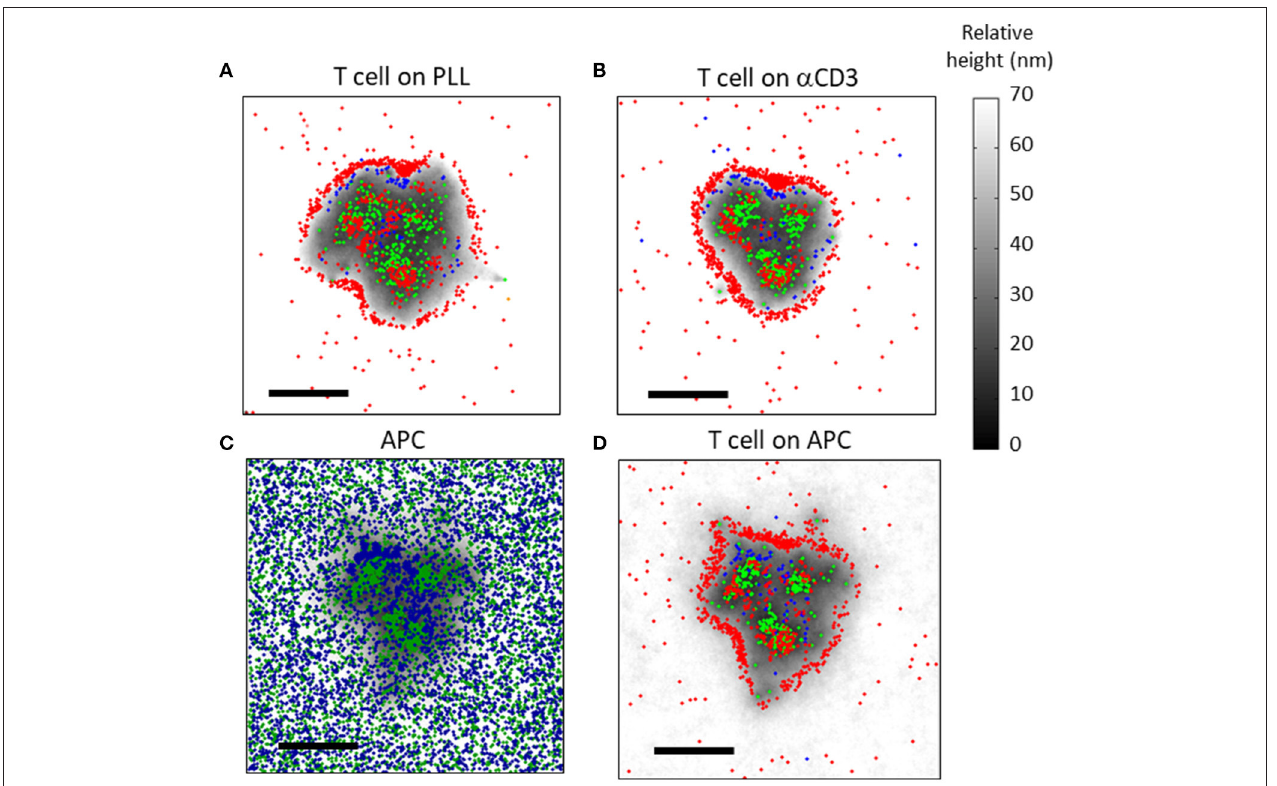
FIGURE 8 | Simulation results of molecular patterning at the immune synapse (A,B) The molecular patterning of TCRs (green), CD11 (blue) and CD45 (red) at the cell interface, on either (A) a PLL-coated or (B) an α CD3-coated coverslip. (C,D) The molecular patterning at the T cell-APC immune synapse. (C) ICAM (blue) and pMHC (green) molecules are shown at the PM of the APC. (D) TCRs (green), CD11 (blue) and CD45 (red) are shown at the PM of the T cell. Membrane height in panels (C,D) is marked by variable gray levels. Bars − 1 µ